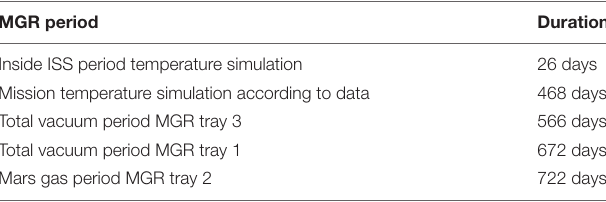
TABLE 4 | EXPOSE-R2 MGR sequence durations overview.